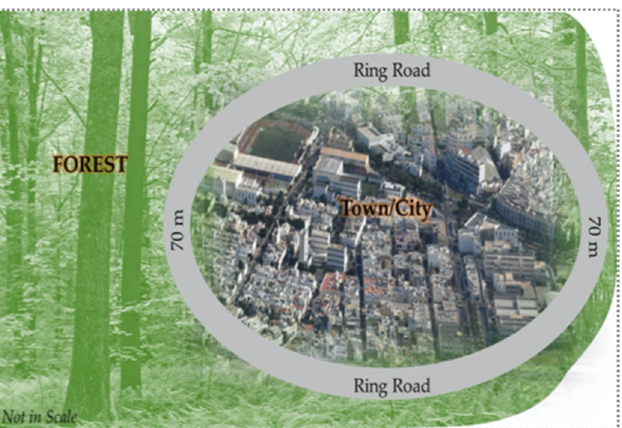
Table 3. Response summary about the construction of a ring road with a width of 70 m.